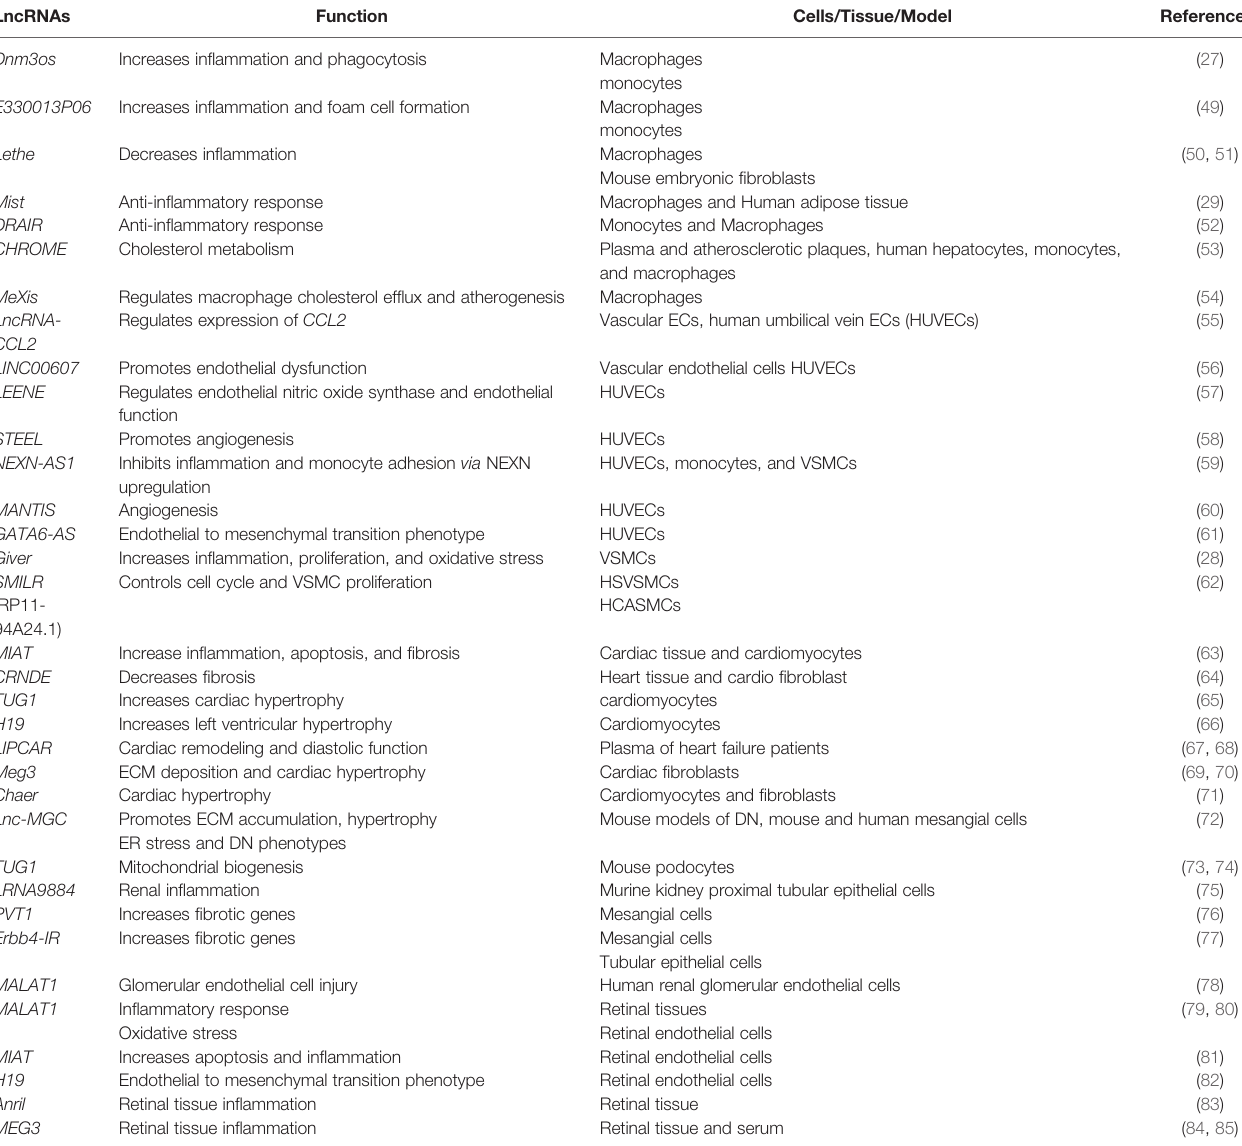
TABLE 1 | Long non-coding RNAs and their functions in in fl ammation and diabetes complications. LncRNAs